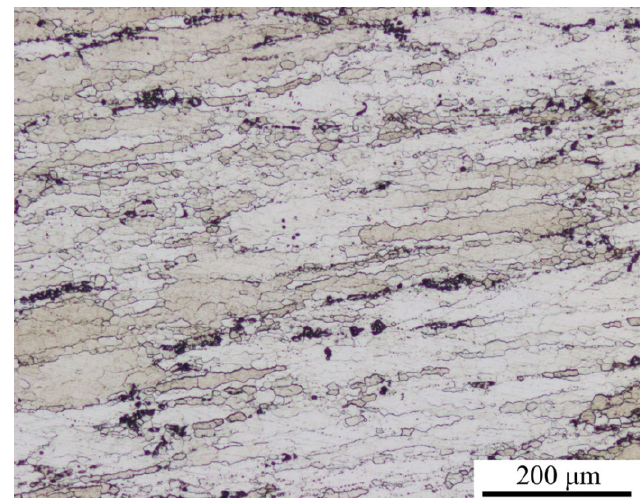
Figure 1. OM (optical microscope) micrograph of 2A14-T6 aluminum alloy.